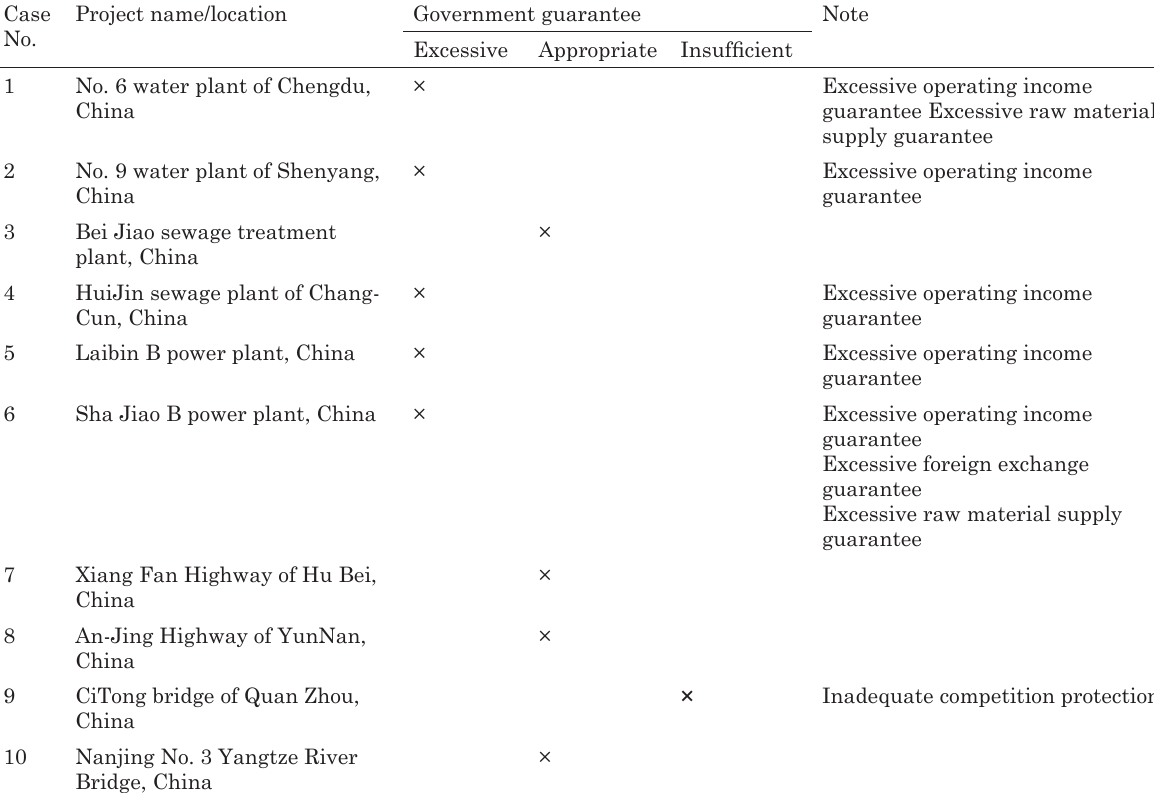
Table 4. Appropriateness of government guarantees provided in ten cases Case